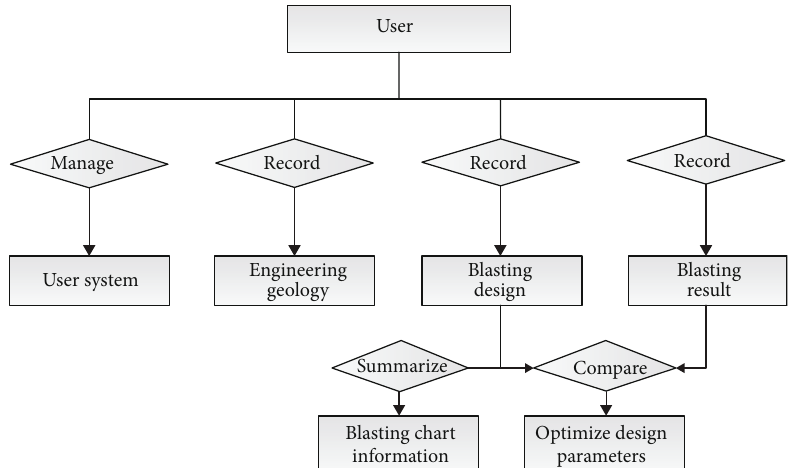
Figure 4: Global E-R diagram of the intelligent design system for mine tunnel blasting based on database.